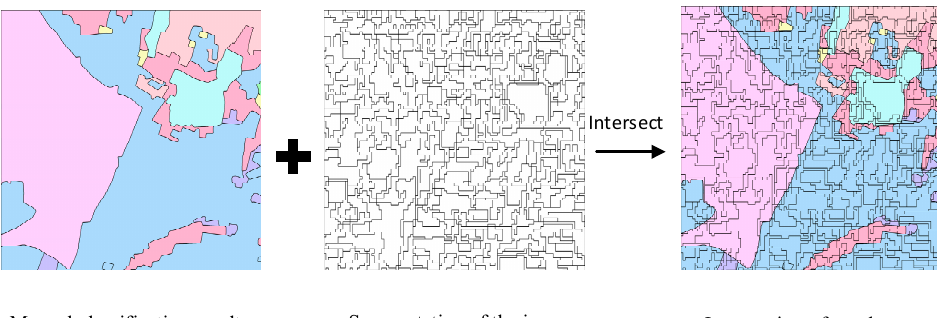
Figure 2. Process to obtain the feature map for graph construction.